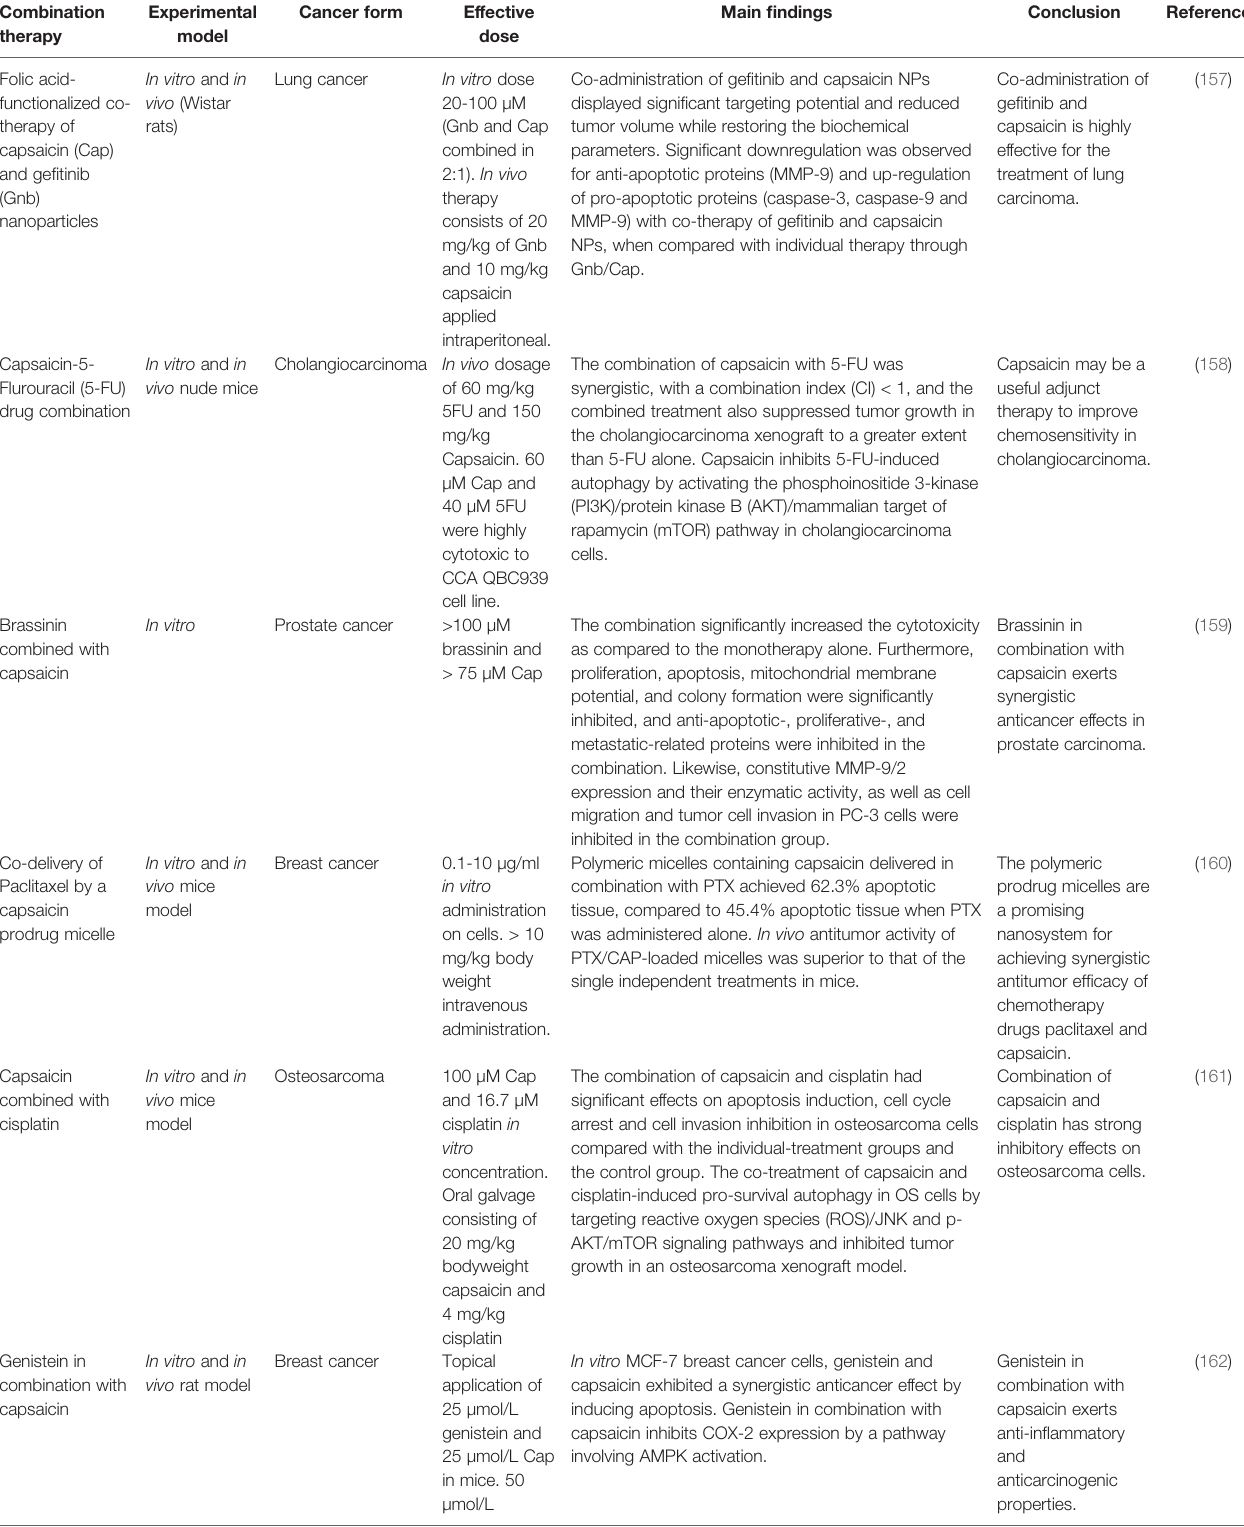
TABLE 2 | Examples of studies on capsaicin combination therapy for improved anticancer